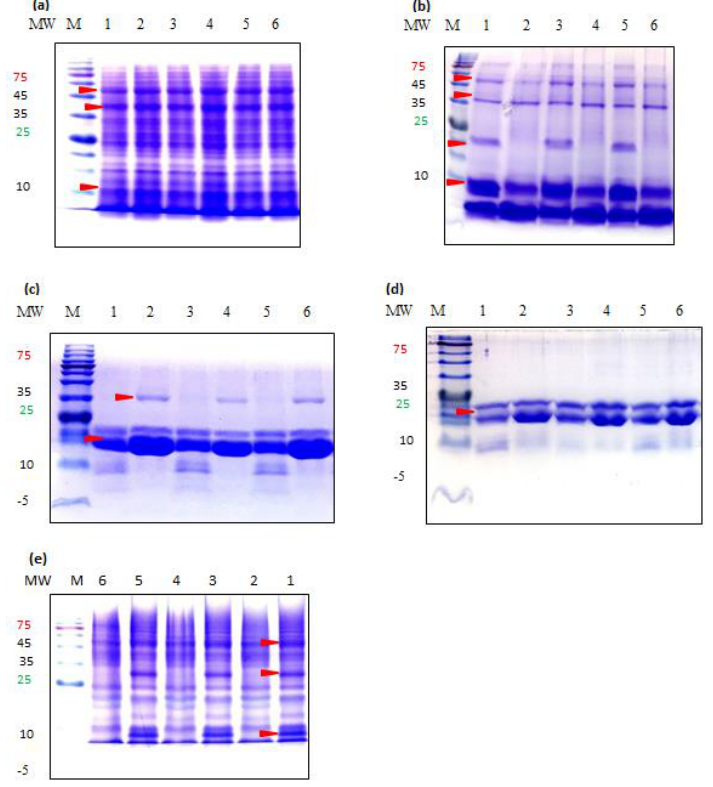
Figure 3. Sodium Dodecyl Sulfate Gel Electrophoresis band patterns of teff protein fractions resolved on a 15% gel under reducing conditions. ( a ) Albumins, ( b ) Globulins, ( c ) Prolamins Method 2, ( d ) Prolamins Method 3, ( e ) Glutelins. MW, molecular weight (kilodaltons); M, marker; Lane 1, Addis-W; Lane 2, Addis-B; Lane 3, Mekel-W; Lane 4, Mekel-B; Lane 5, Debre-W; Lane 6, Debre-B.